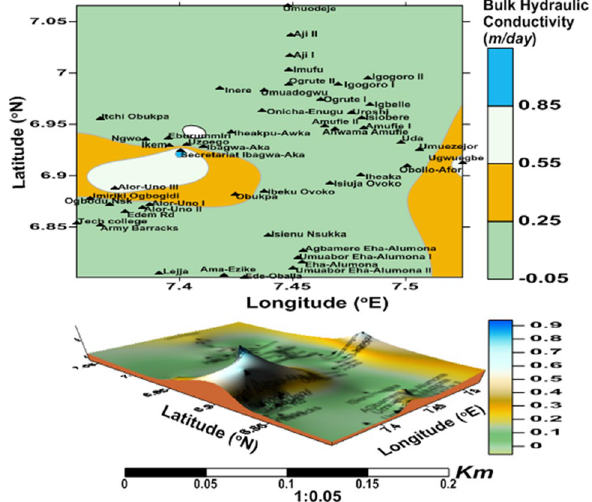
Fig. 8 2D and 3D contour map showing the variation of bulk hydrau- lic conductivity in the study